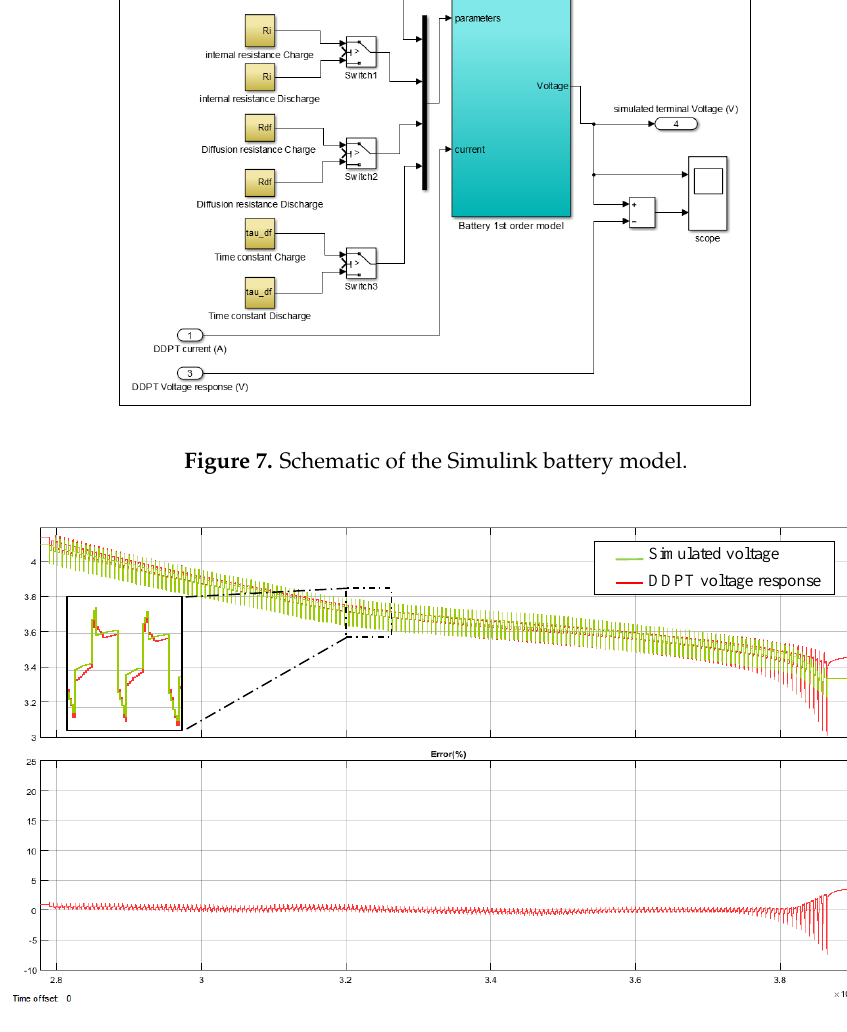
Figure 8. Schematic of the Simulink battery model.